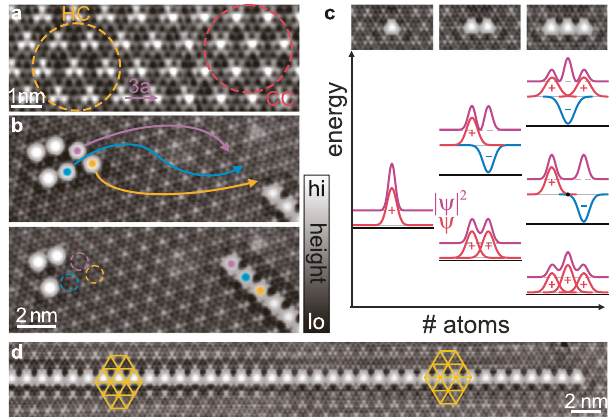
Fig. 1 Assembly of Fe chains on NbSe 2 . a Atomic-resolution topography of a clean NbSe 2 surface. Regions with HC (CC) CDW patterns are indicated in yellow (red). b Topography images illustrating the sequence of atomic- manipulation steps to obtain an Fe chain. c STM images of Fe monomer, dimer, and trimer along with a schematic illustration of YSR hybridization. YSR wave functions of the monomers (taken as Gaussian shaped) with red and blue indicating positive and negative amplitude in overall hybridized (cid:1) (cid:1) (cid:1) (cid:1) 2 shown in purple). A tight-binding-like wave function ψ (with ψ hybridization into linear combinations of monomer wave functions predicts characteristic maxima and nodal planes of the YSR wave function. d Topography of a long chain. The yellow grids illustrate the position of the CDW maxima relative to the atoms of the chain. Constant-current set point for all topographies 100 pA, 10